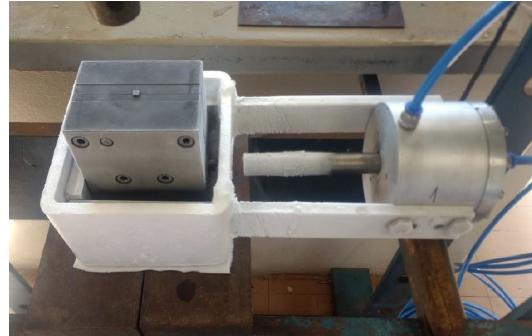
Figure 1. Picture of the ECAP system used for CT